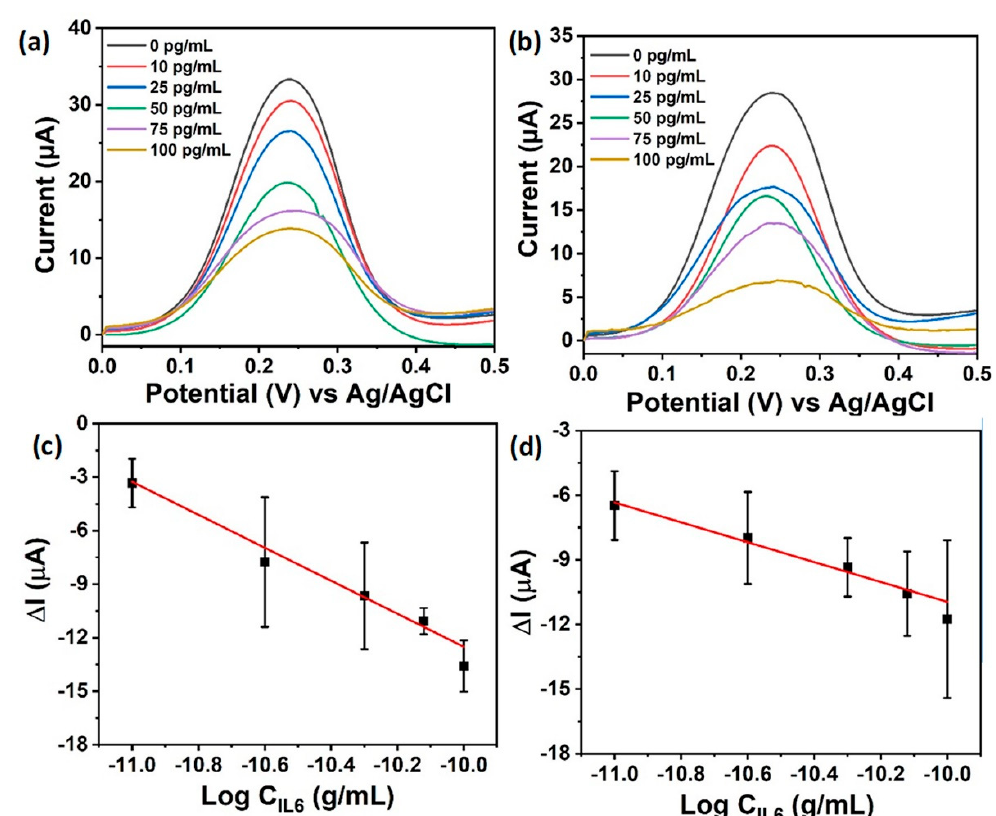
Figure 4. DPV curves of graphitic carbon biosensor at varying concentrations of IL-6 conducted in 0.1 M PBS at pH 7.4 containing 5 mM Fe(CN) 6 ] 3 − /4 − in ( a ) 10% serum and ( b ) 10% BSA; change of the DPV peak current of GC biosensor vs. Ag/AgCl at varying IL-6 concentration in ( c ) 10% serum and ( d ) 10% BSA, n = 3.